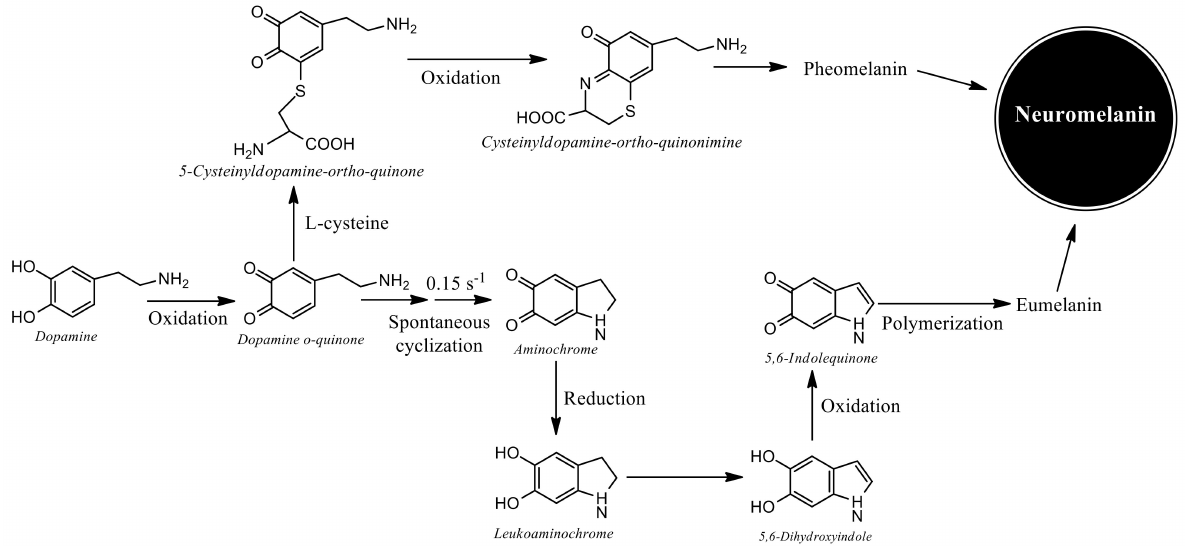
Figure 2. Synthesis of melanin. The synthesis of neuromelanin requires the oxidation of the catechol group of dopamine, where three ortho-quinones are generated in a sequential manner (dopamine ortho-quinone, aminochrome, and 5,6-indolequinone). Dopamine ortho-quinone is the first intermedi- ate formed when the hydroxy groups of dopamine are oxidized. This ortho-quinone is stable at a pH lower than 2.0, which implies that at physiological pH in the cytosol it cyclizes in two steps